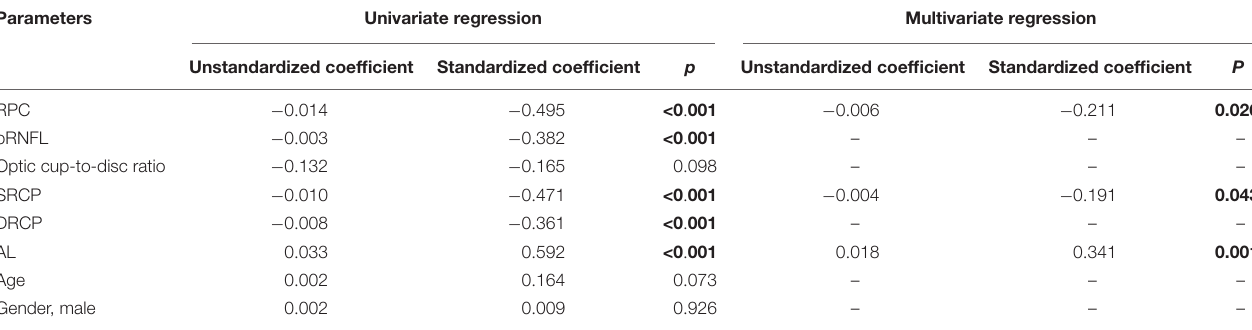
FIGURE 2 | ROC curve of the RPC density, pRNFL thickness, and macular retinal microvascular density for discriminating the pathological myopia. (A) The ROC curves of the RPC density, pRNFL thickness, SRCP, and DRCP density in the global area for discriminating the pathological myopia. The AUC values were 0.962, 0.675, 0.824, and 0.865, respectively. (B) The ROC curves of the RPC density in the four respective sectors (nasal-superior, nasal-inferior, inferior-nasal, and inferior-tempo) for discriminating the pathological myopia. The AUC values were 0.748, 0.749, 0.735, and 0.786, respectively. (C) The ROC curves of the RPC density in the four respective sectors (tempo-inferior, tempo-superior, superior-tempo, and superior-nasal) for discriminating the pathological myopia. The AUC values were 0.861, 0.850, 0.852, and 0.772, respectively. RPC, radial peripapillary capillary; pRNFL, peripapillary retinal nerve fiber layer; SRCP, superficial retinal capillary plexus; DRCP, deep retinal capillary plexus. TABLE 5 | Linear regression analysis based on the BCVA as the outcome.